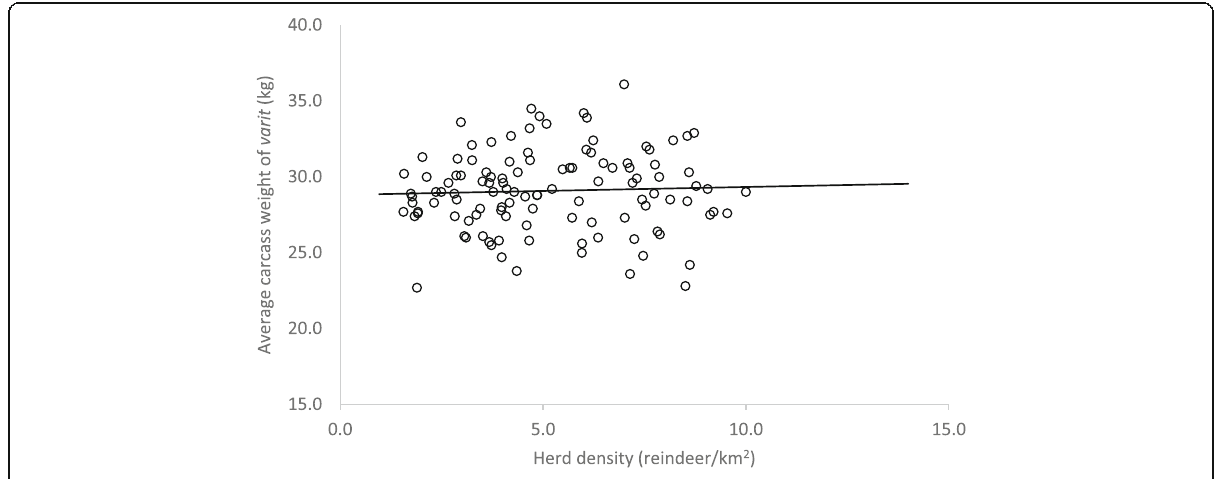
Fig. 6 Relationship between carcass weights of varit and herd density in island districts of Western Finnmark (data source: MAF)